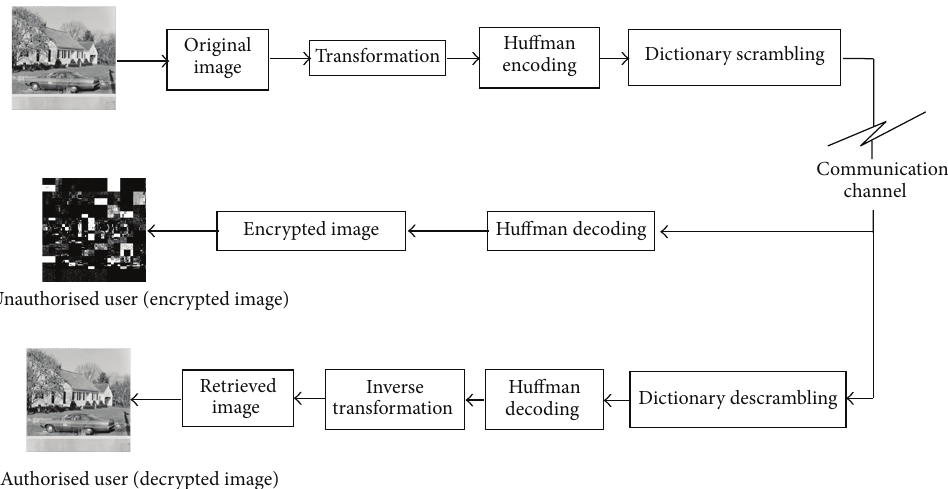
Figure 1: Block diagram for the proposed